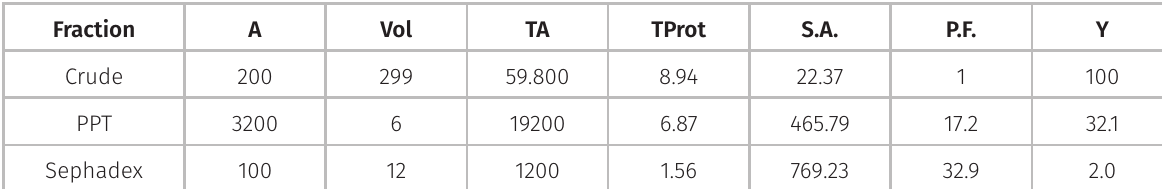
Table I. Concentration of soluble proteins and antimicrobial activity from the fractions resulting from the purification steps, produced by Bacillus sp. sed